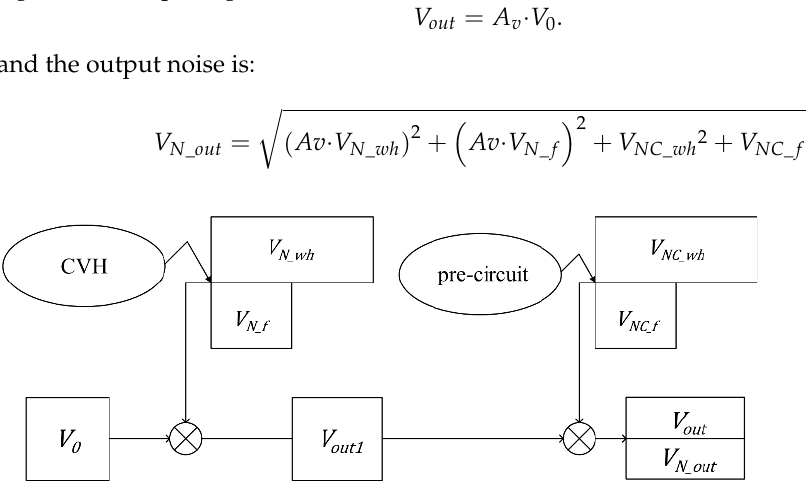
Figure 6. Signal transmission process of a single CVH.